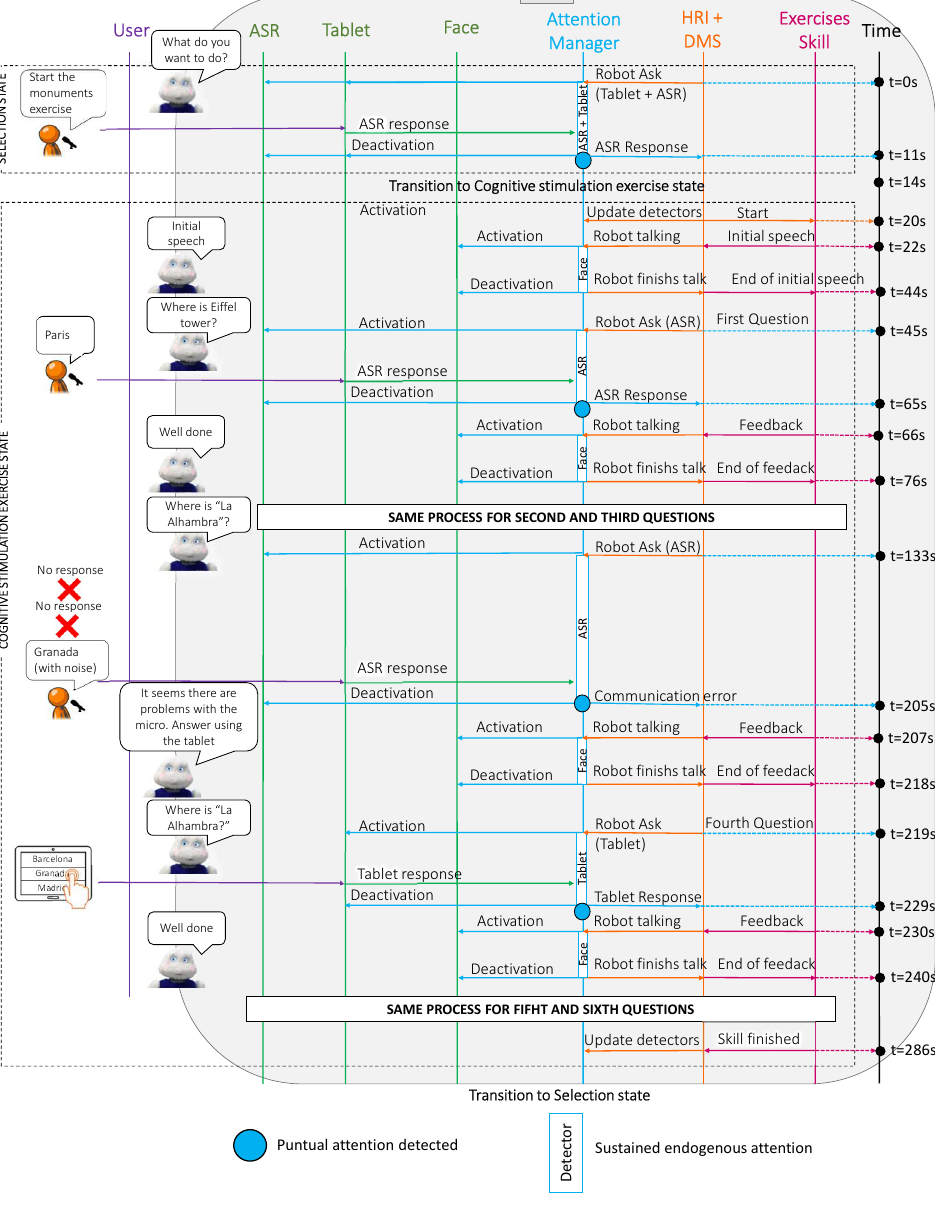
Figure 8. A sequence diagram of the connections between the different software blocks in the Mini during the execution of the cognitive stimulation